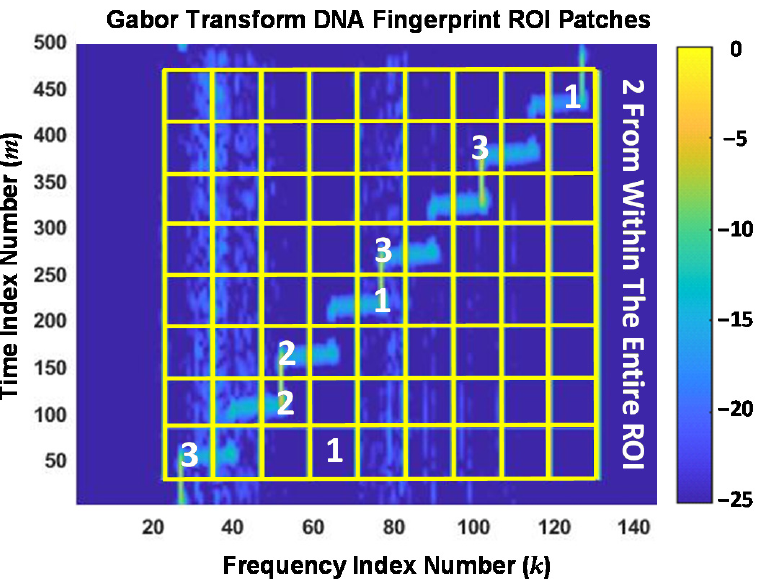
Figure 9. Gabor transform and ROI patch overlay from Figure 6 with numerical values added to indicate the number of jointly selected RndF and LVQ features generated within the patches. The numbers identify 1-of-18, 2-of-18, or 3-of-18 features from among the N Joint = 18 features identified by the green triangle ( ▽ ) markers in Figures 7 and 8.